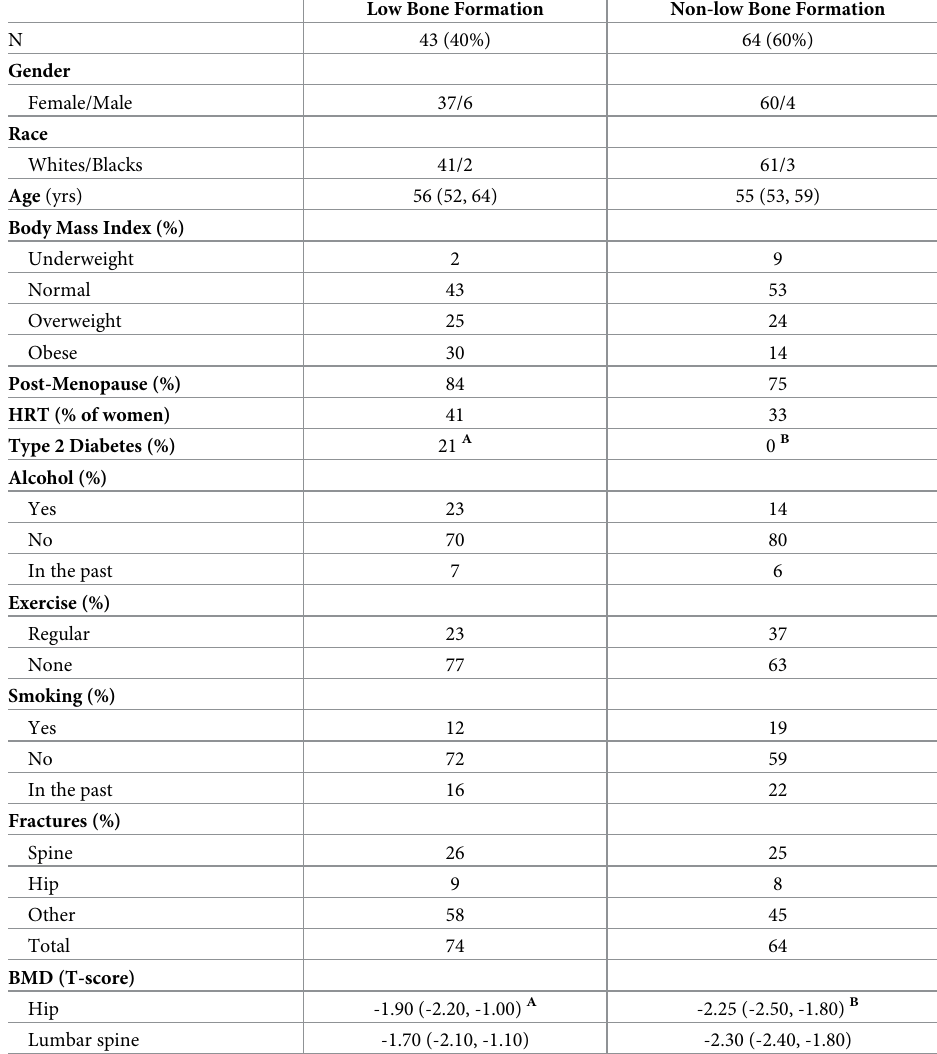
Table 1. Clinical characteristics of patients with different bone formation rates in trabecular